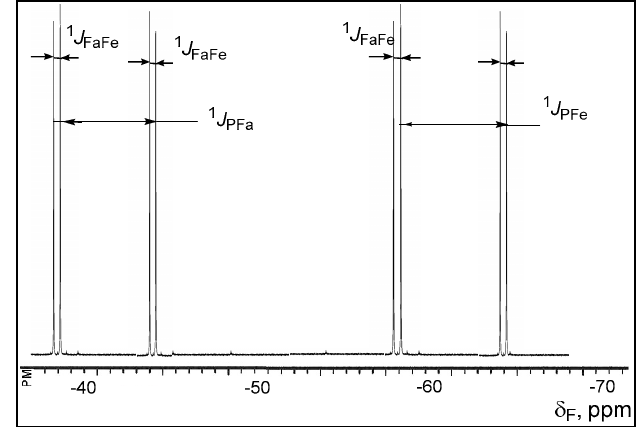
Figure 2. 19 F-NMR spectra of 2-(diethylamino)-2,2-difluoro-4-tolyl-3-propyl-4-(trifluorophenyl-1,2 λ 5 - oxaphosphetane 31 (see Table 2, entry 15).